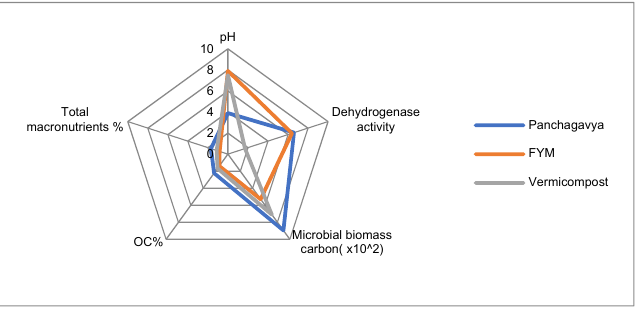
Figure 1. Microbiological quality and impacts of different organic fertilizers [3].